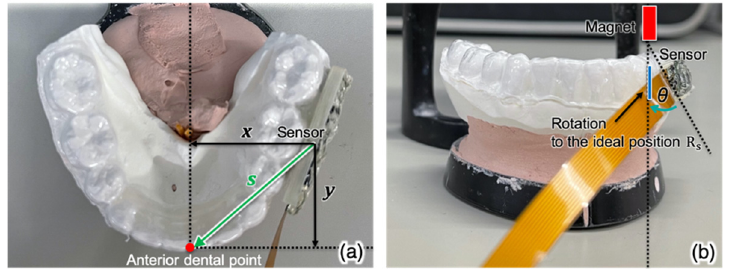
Figure 3. Translation of data from the molar to the anterior dental point. ( a ) Superior view; ( b ) frontal view.